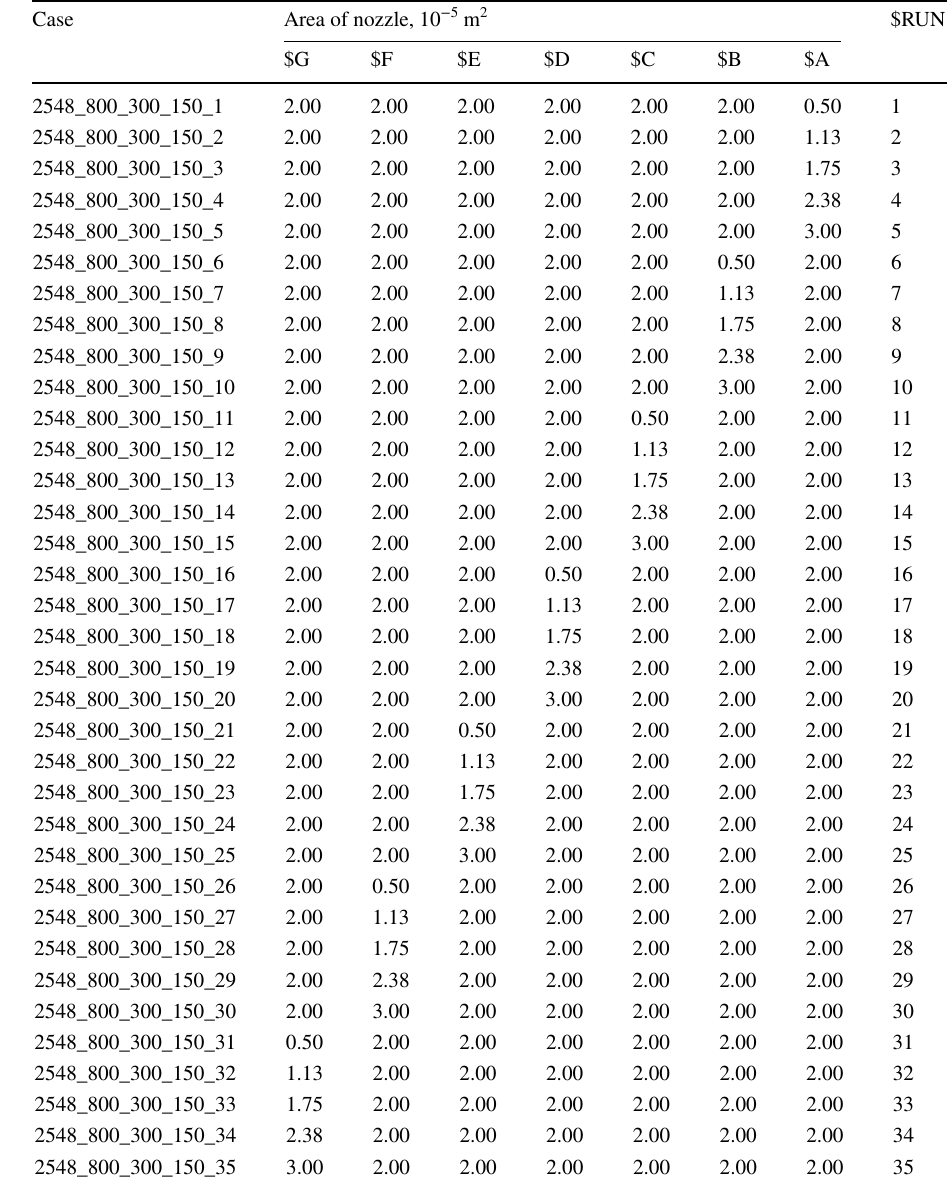
Table 8 Details of all the cases examined for variable nozzle